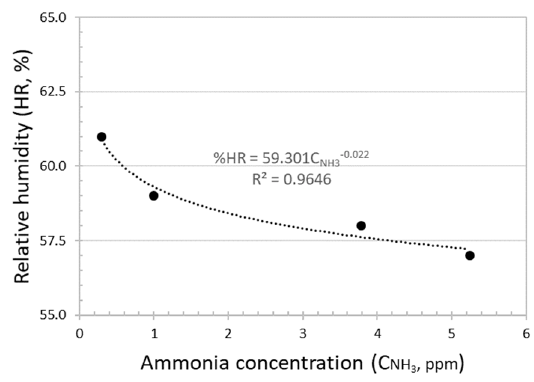
Figure 2. Exponential fit of NH 3 concentration and relative humidity (RH) in the animal-occupied zone.